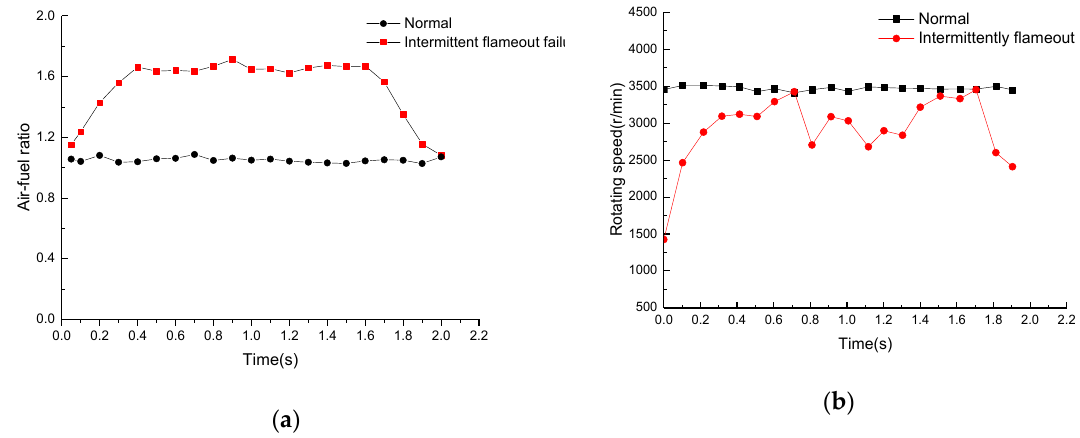
Figure 8. Charts of speed and air-fuel ratio changing with time. ( a ) Chart of air-fuel ratio versus time, ( b ) Change chart of transient speed.